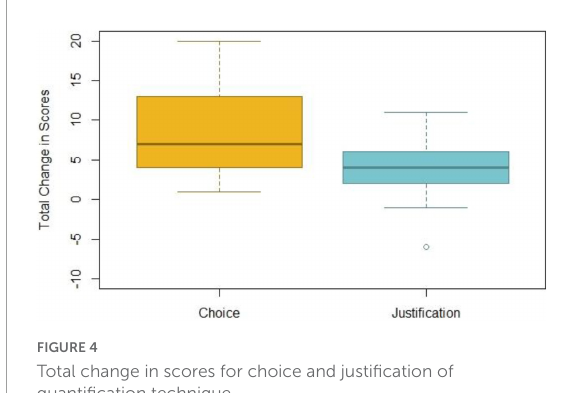
FIGURE4 Total change in scores for choice and justification of quantification